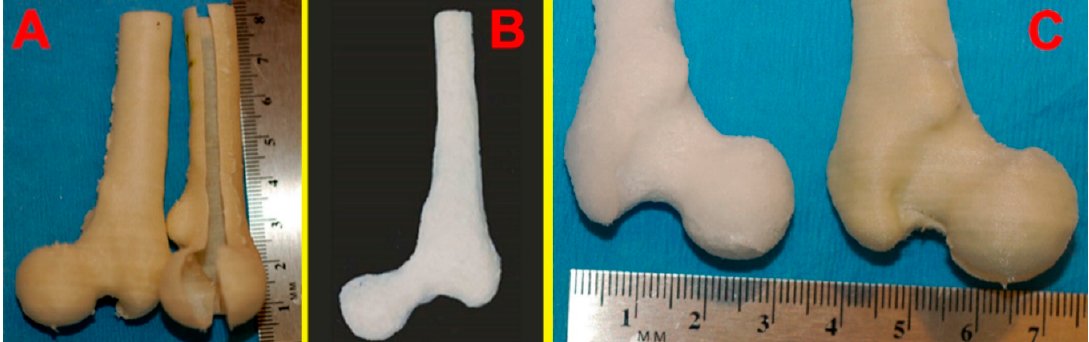
Figure 2. Two identical molds were successfully 3D printed as demonstrated in ( A ), one of which was sliced open to show the interior. The anatomically-shaped scaffold was also successfully generated as shown in ( B ) and it has the same detailed external anatomical characteristics as the mold ( C ).